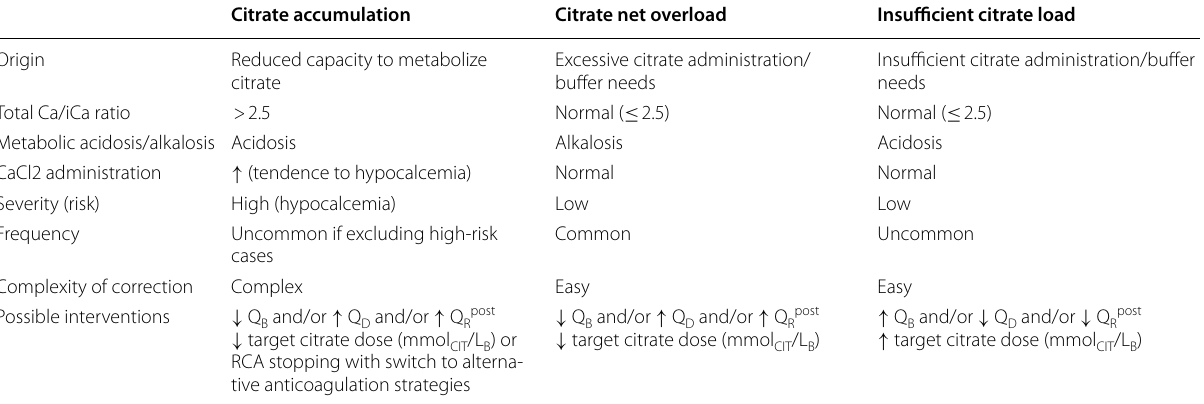
Table 2 Differential diagnosis between citrate accumulation and other benign